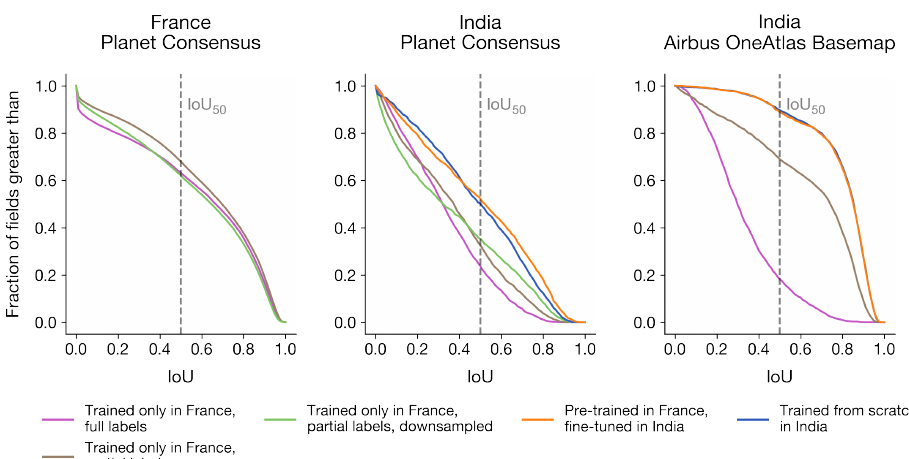
Figure 6. IoU curves in France and India. The x -axis shows the intersection-over-union (IoU) metric, and the y -axis shows the fraction of fields in the test set with an IoU above that threshold. Results are shown for five models: (1) trained only on France data (full labels), (2) trained only on France data (partial labels), (3) trained only on France data (partial labels, downsampled), (4) pre-trained on France data and fine-tuned in India, and (5) trained from scratch in India. Curves toward the upper right correspond to higher